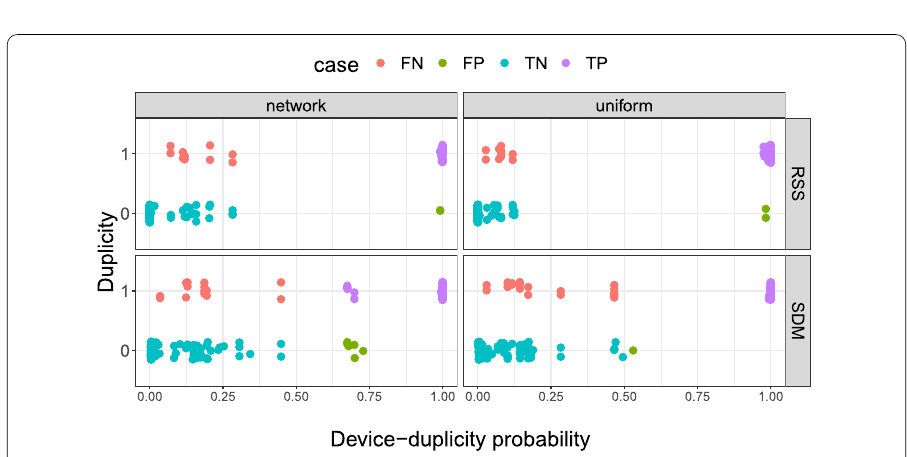
Figure 9 Cases for the duplicity probabilities p (2) . True/false positive/negative cases for the duplicity d probabilities p (2) = 1 – p (1) computed according to eq. (9) for four different HMMs with two priors and two d d emission